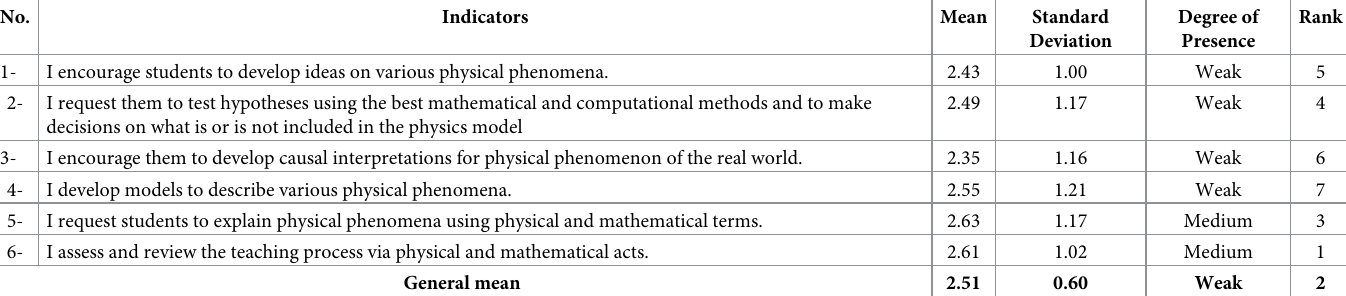
Table 3. The means and standard deviations of the presence of the “developing and using models” practice.